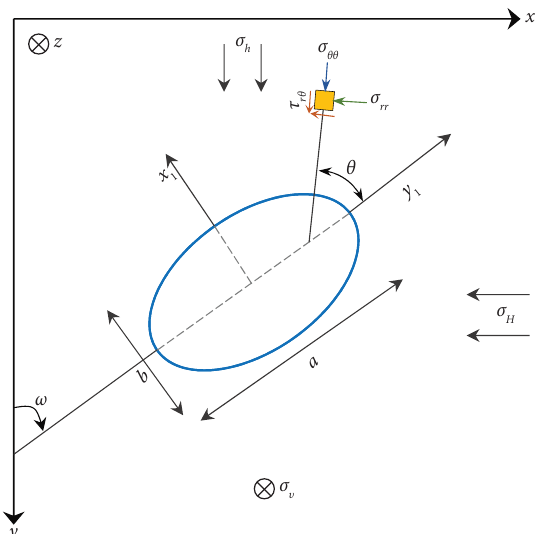
Figure 2: Elliptical borehole, global and local axes, and in situ